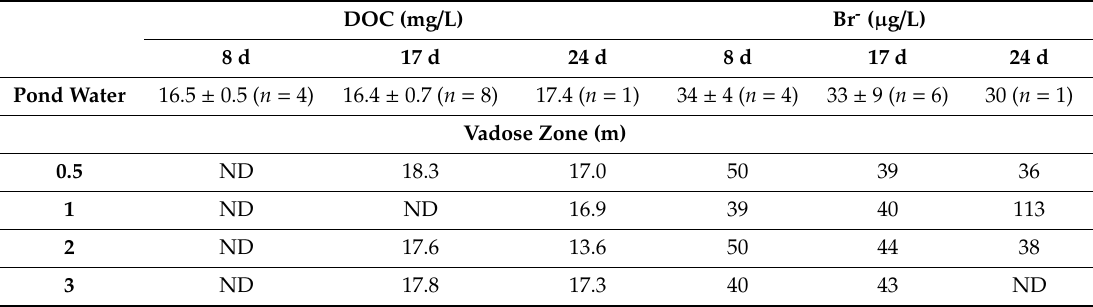
Table 3. DOC and bromide concentration in the ponding water and vadose zone 8, 17, and 24 d after the infiltration began. Pond water samples were collected at multiple points (number of sampling points provided in brackets). (ND—No